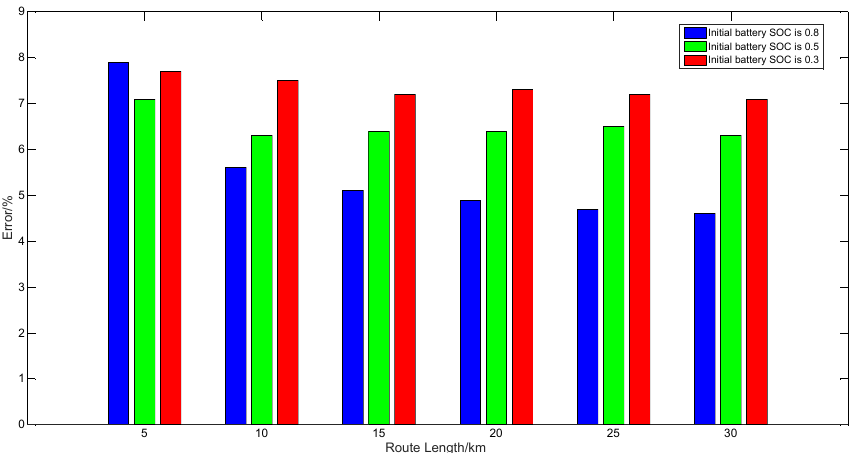
Figure 10. TEEM performance with various route lengths and initial battery